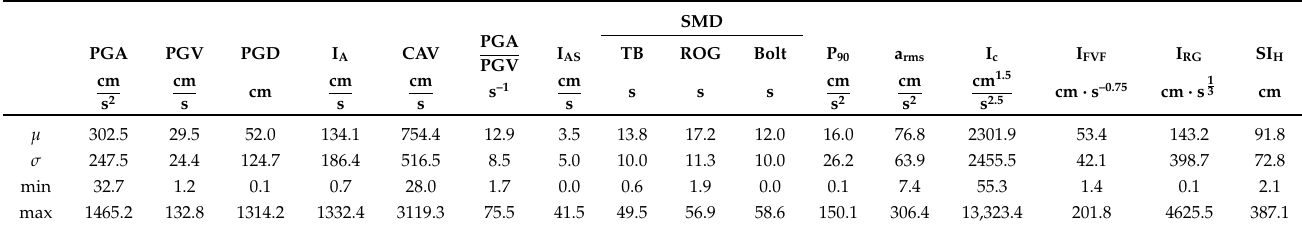
Table A1. Descriptive statistics for the IMs of the 318 individual records.